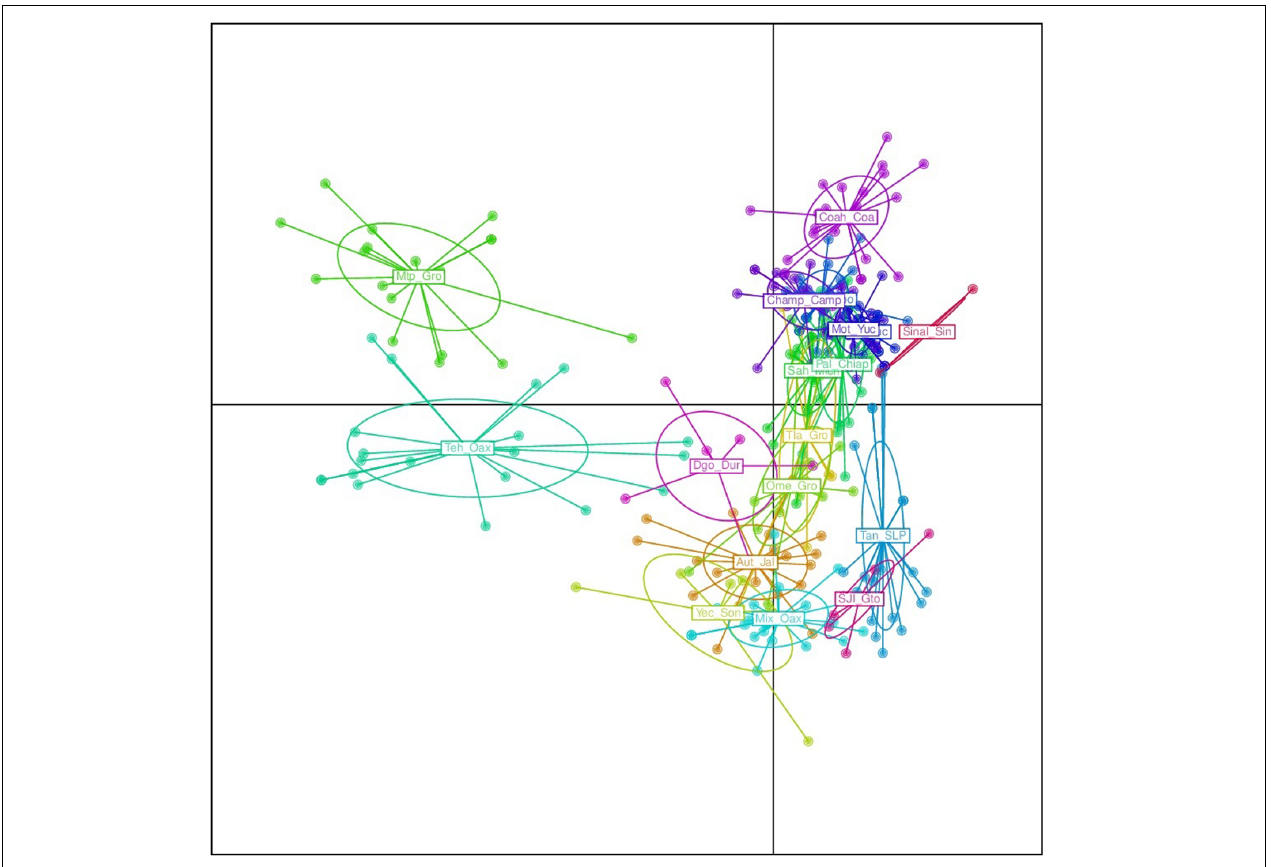
FIGURE 6 | Discriminant analysis of principal components (DAPC) for only 18 argyrosperma populations (excluding Tih). Mtp and Teh from the states of Guerrero and Oaxaca, respectively, are well differentiated. Population ID are as shown in Table 1